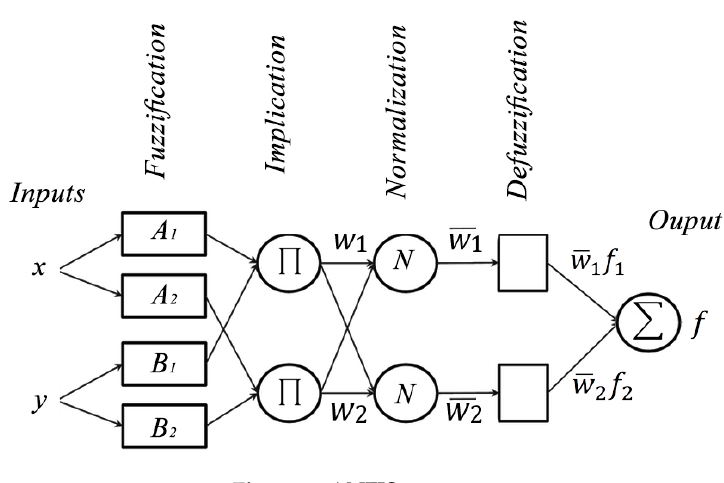
Figure 1. ANFIS Figure 1. ANFIS structure.